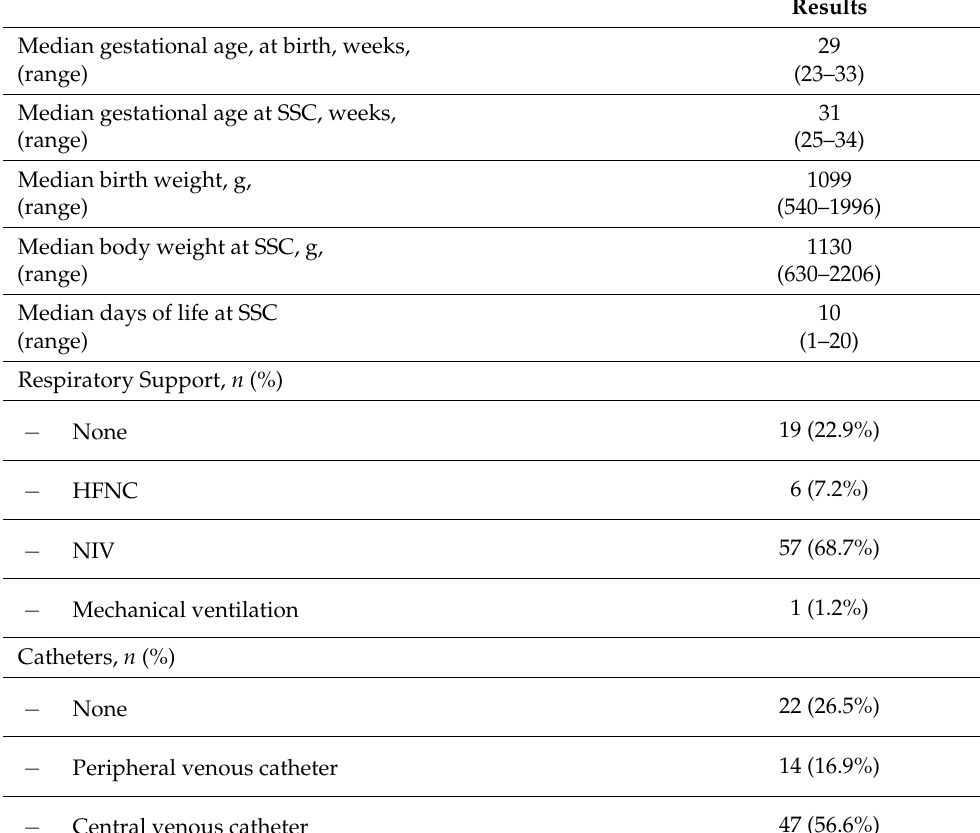
Table 1. Clinical characteristics of infants before and during an SSC